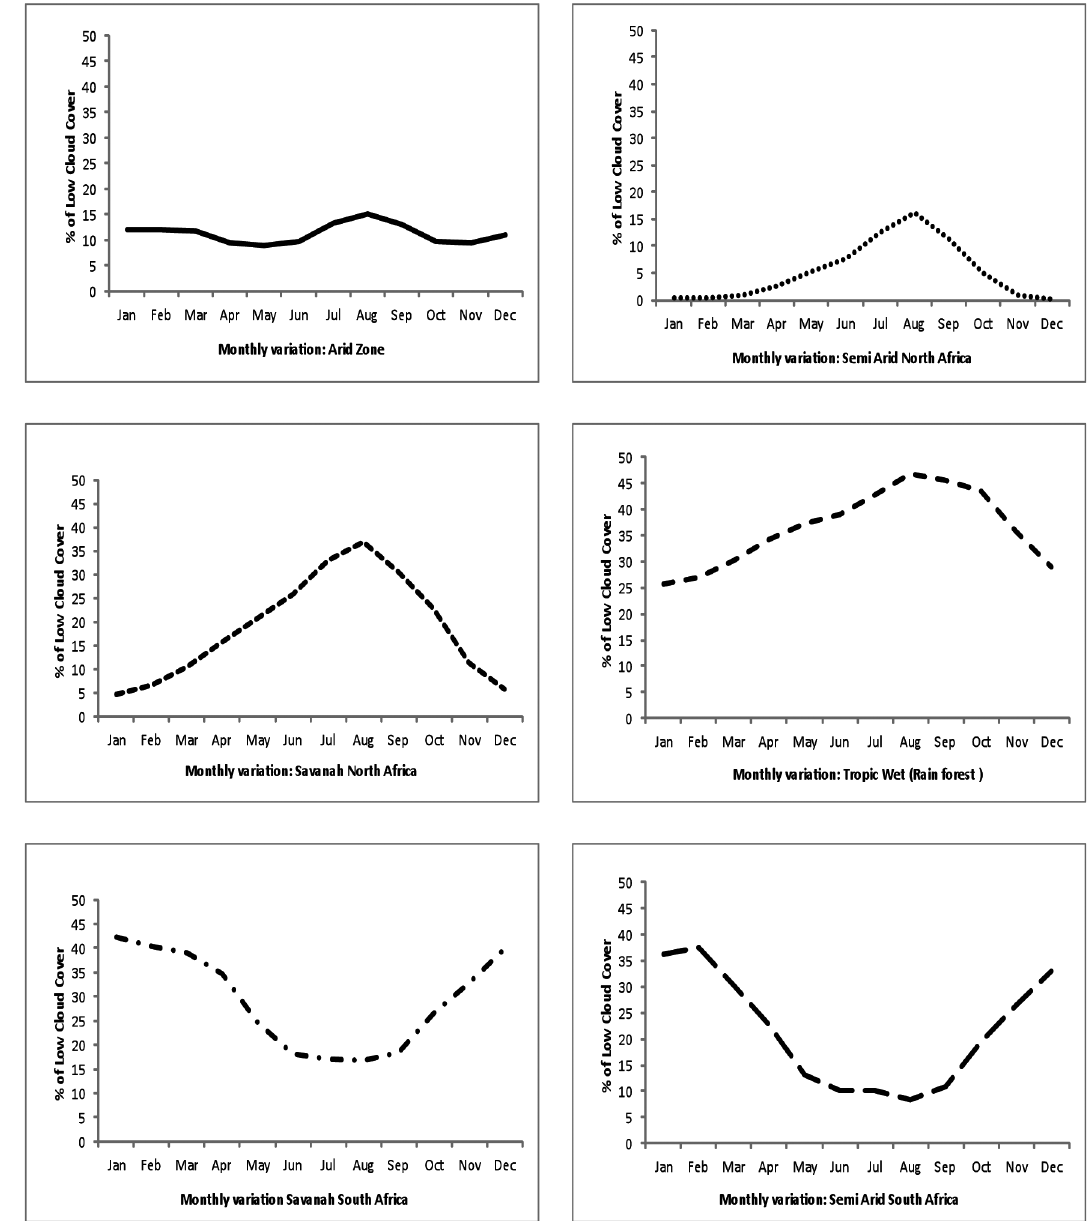
Figure 4. Monthly distribution of low cloud cover in the six major climatic